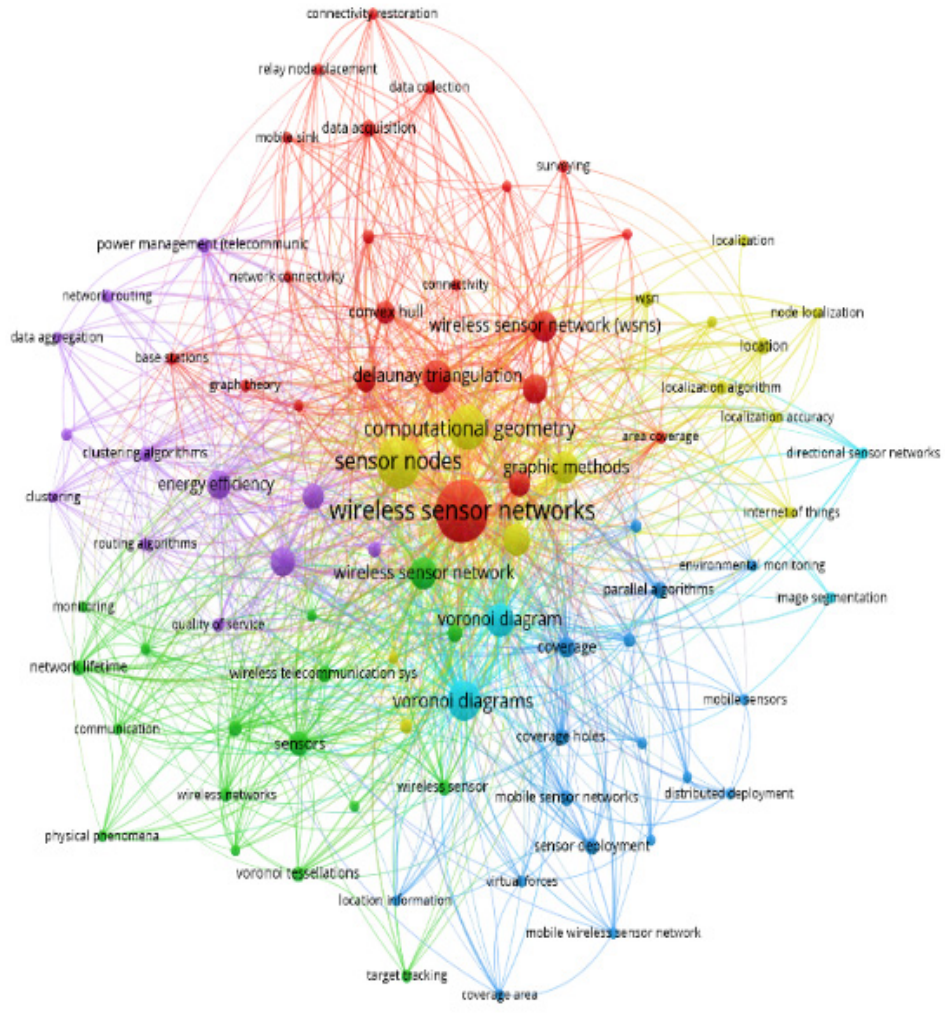
Figure 3. The network visualization of co-occurrence of all keywords using the VOSviewer.